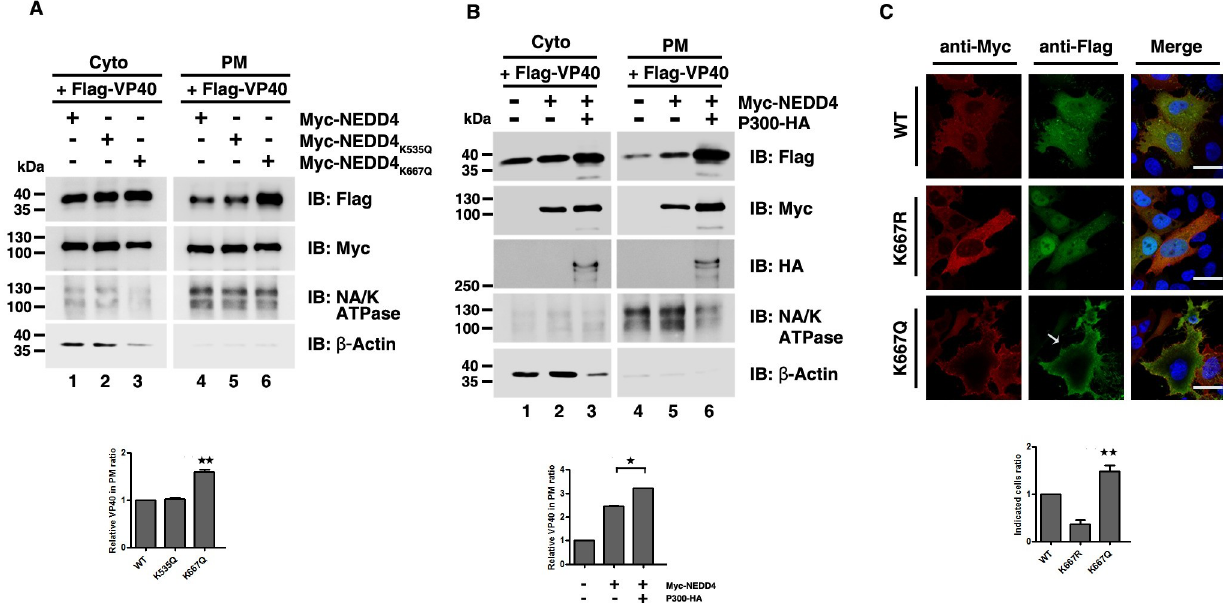
Fig 6. NEDD4 acetylation alters VP40 subcellular localization. (A) Separation of the cytoplasm and the plasma membrane was conducted to detect the influence of the acetylation-mimicking mutants of NEDD4 on the plasma membrane localization of VP40. (B) Separation of the cytoplasm and the plasma membrane was conducted to detect the influence of P300 on the plasma membrane localization of VP40. (C) HeLa cells were transfected with the indicated plasmid combinations to visualize VP40 localization. The white arrow represents the localization pattern of VP40 at the plasma membrane and in PM projections. DAPI (blue) was used to stain nuclear DNA. Scale bar, 10 μ m. Error bars, mean ± SD of three experiments. Student’s t test; � p < 0.05; �� p < 0.01; ��� p < 0.001.